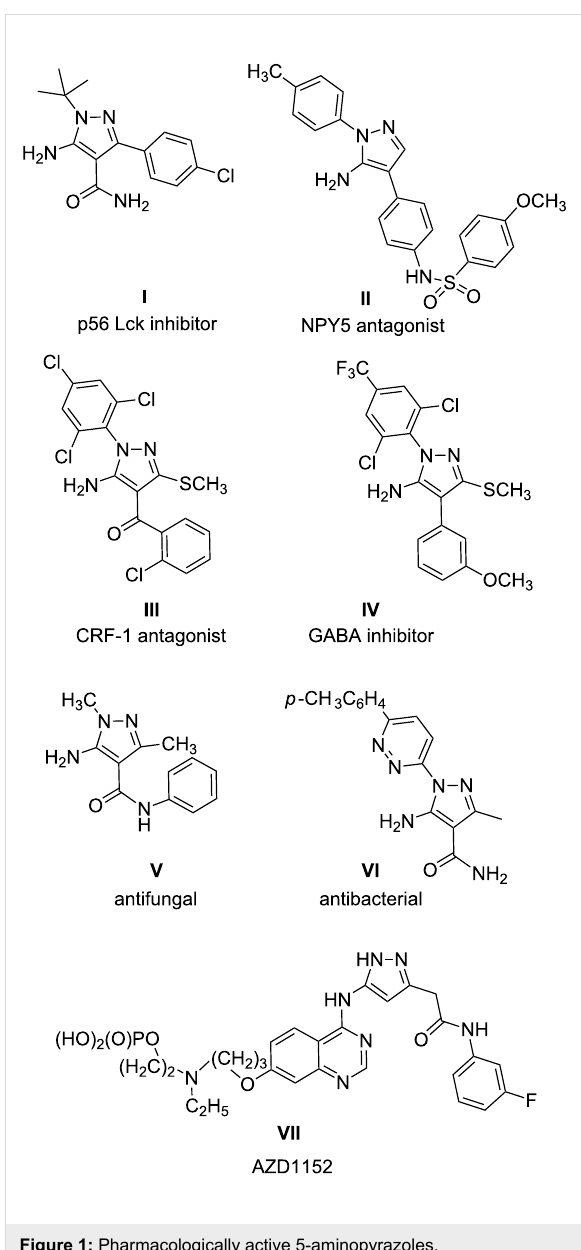
Besides the importance of 5-aminopyrazoles as biologically active agents, they are also useful synthons and building blocks for many heterocyclic products and can act as a binucleophile [14-18]. Cyclocondensation of 5-aminopyrazoles with